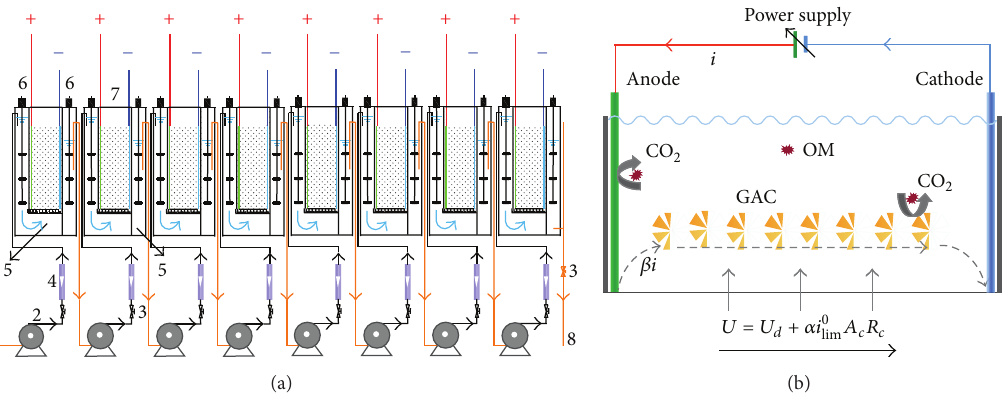
Figure 2: Treatment process of phenol wastewater. (a) Treatment process of phenol wastewater. (b) Oxidation mechanism of organics in a single